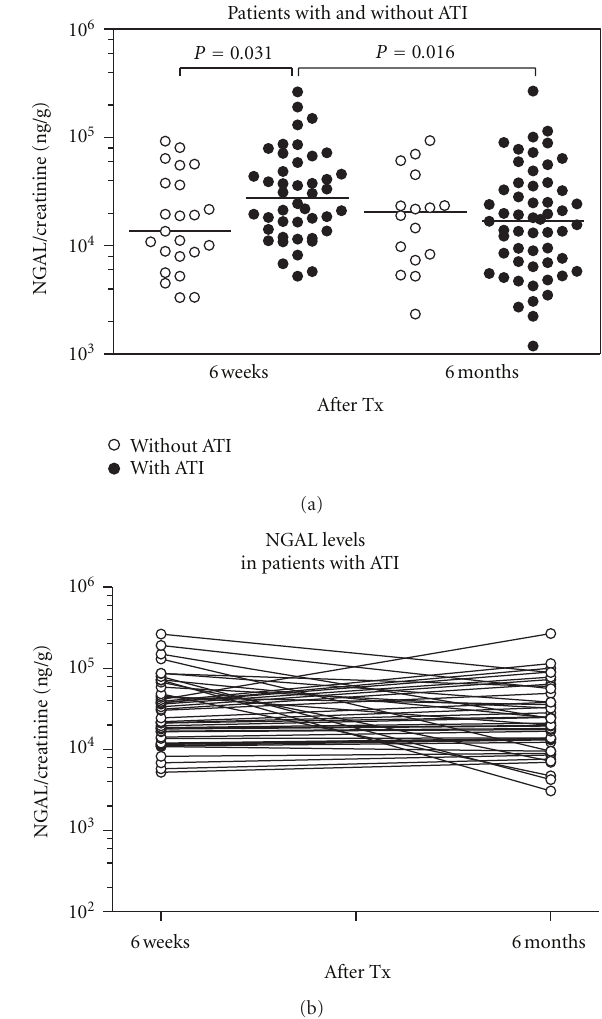
Figure 3: (a) Comparison of urinary NGAL/creatinine ratios in patients with and without ATI after kidney transplantation. Patients with ATI 6 weeks ( n = 44) after transplantation have significantly higher urinary NGAL levels than patients without ATI ( n = 23). In patients with ATI, the urinary NGAL excretion at 6 months ( n = 55) is significantly lower than at 6 weeks. No di ff erence in uNGAL ratios was seen between patients with and without ATI at 6 months. (b) Individual course of NGAL levels in patients with ATI at 6 weeks and 6 months after transplantation. Patients with singular measurement are presented by single values only (dots; n = 11 patients for the 6-month measurements). Serial measurements: n = 44 patients for 6 weeks and 6 months (connected by